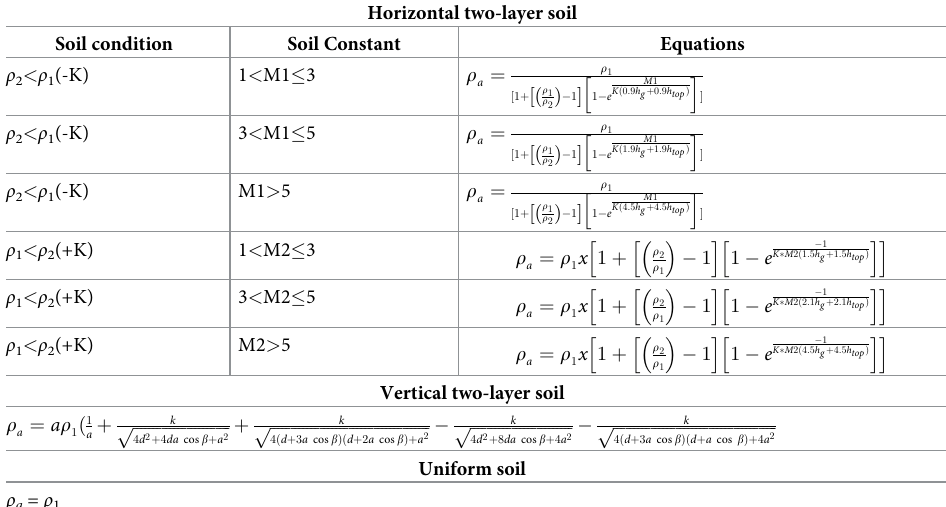
p k ffiffiffiffiffiffiffiffiffiffiffiffiffiffiffiffiffiffiffiffiffiffiffiffiffi k ffiffiffiffiffiffiffiffiffiffiffiffiffiffiffiffiffiffiffiffiffiffiffiffi 4 d 2 þ 4 da cos b þ a 2